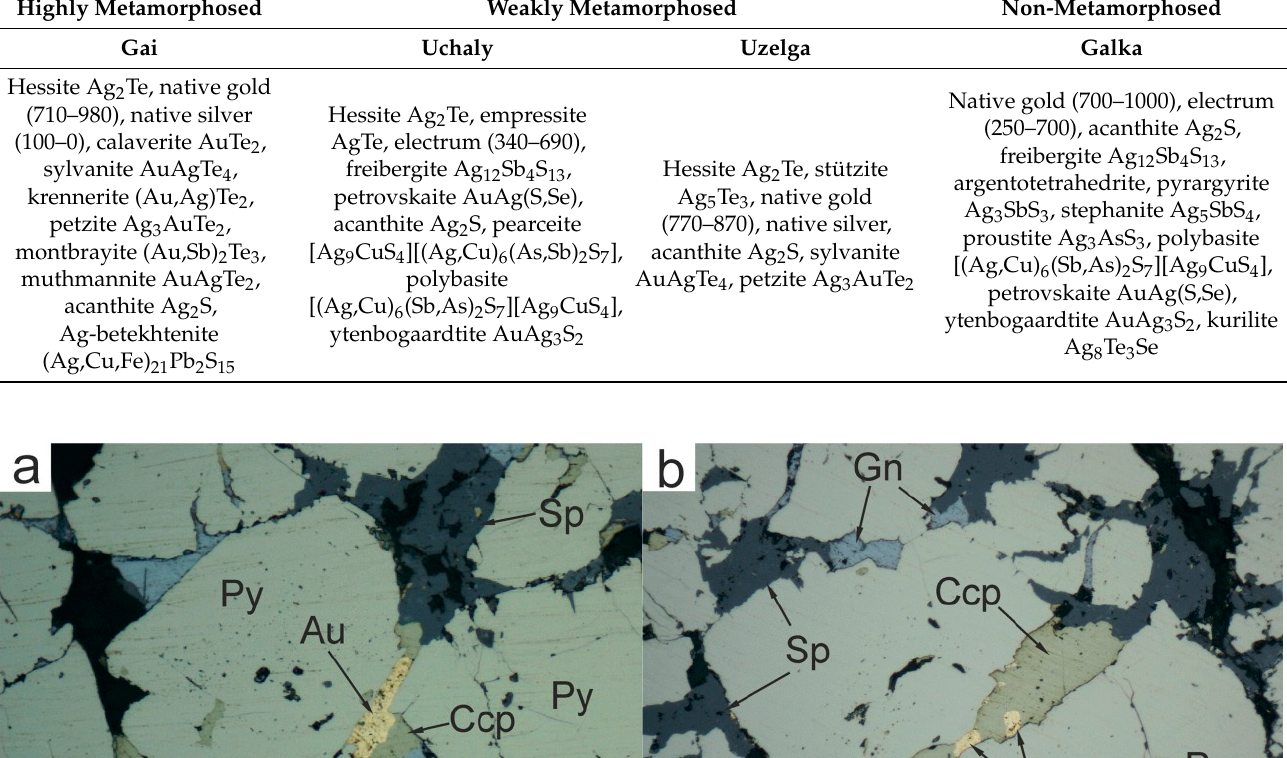
Table 18. Mineral forms of Au and Ag in the largest VMS deposits of the Urals, modified after [93]. Highly Metamorphosed Weakly Metamorphosed Non-Metamorphosed Gai Gai Uchaly Uzelga Galka